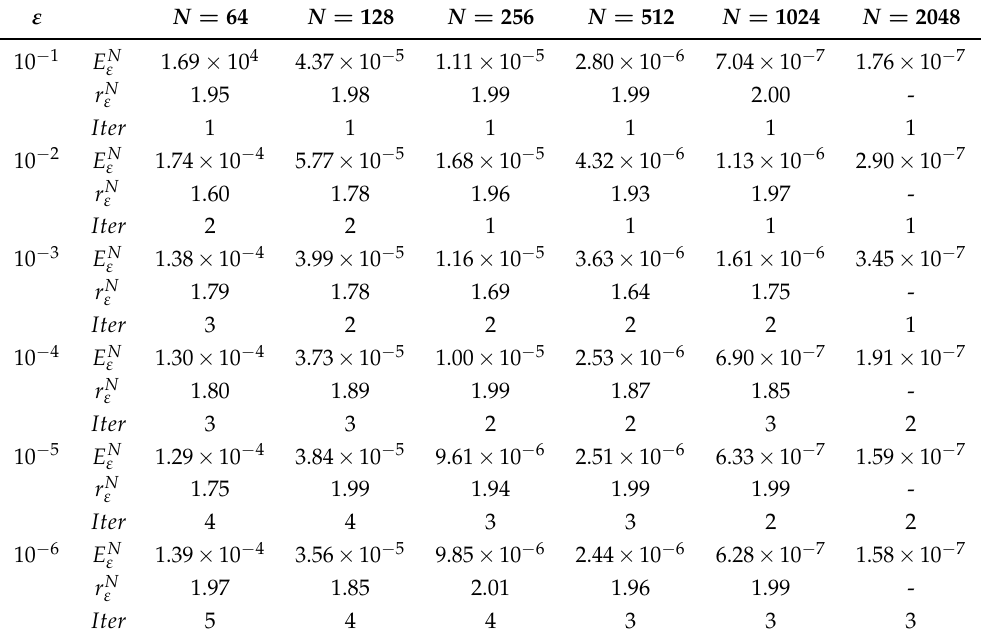
Table 1. Numerical results of our presented adaptive grid method for Example 1.